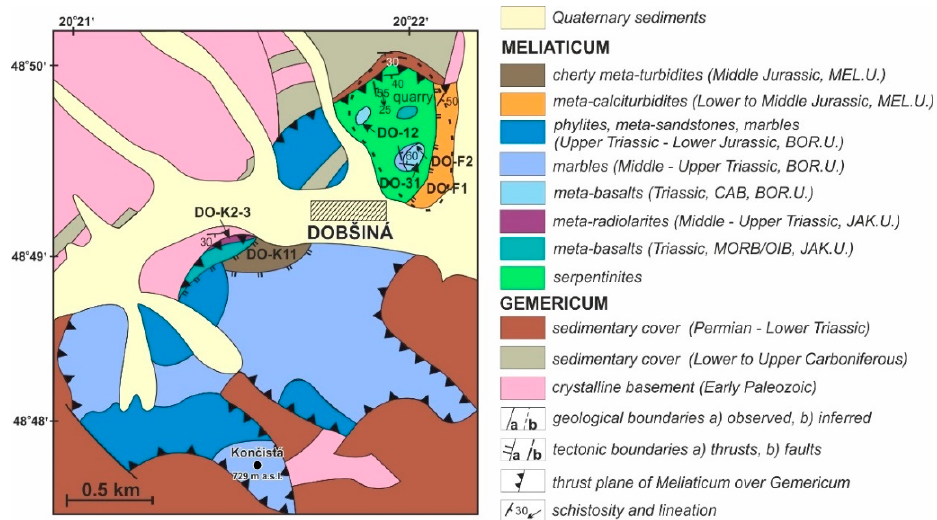
Figure 3. Schematic geological map from Dobšiná area with mélange blocks of the Meliatic paleotectonic units [48]. Modified from [48,50]. Dashed line—the limits of the quarry.